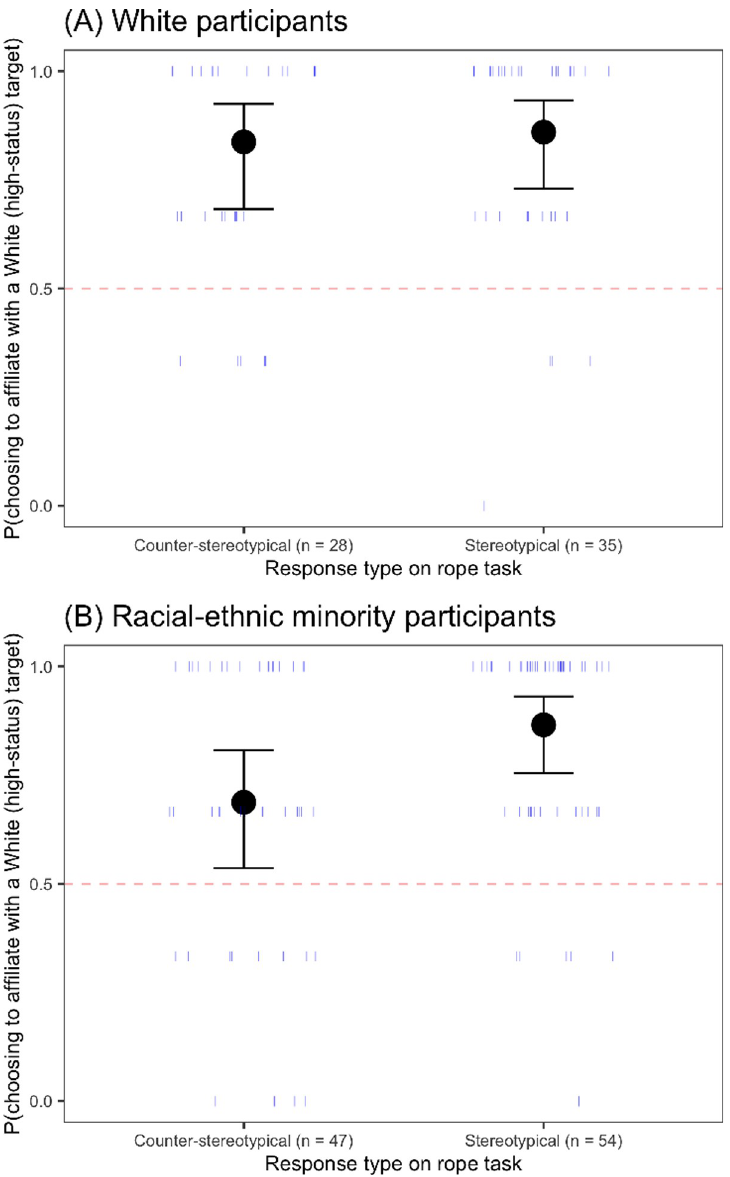
Fig 7. Probability of choosing to affiliate with a White (high-status) child as a function of response type on the rope task and participant race for (A) White participants and (B) Racial-ethnic minority participants. Circles represent the means for each group, and error bars represent 95% confidence intervals around the means; dashes represent individual participants.